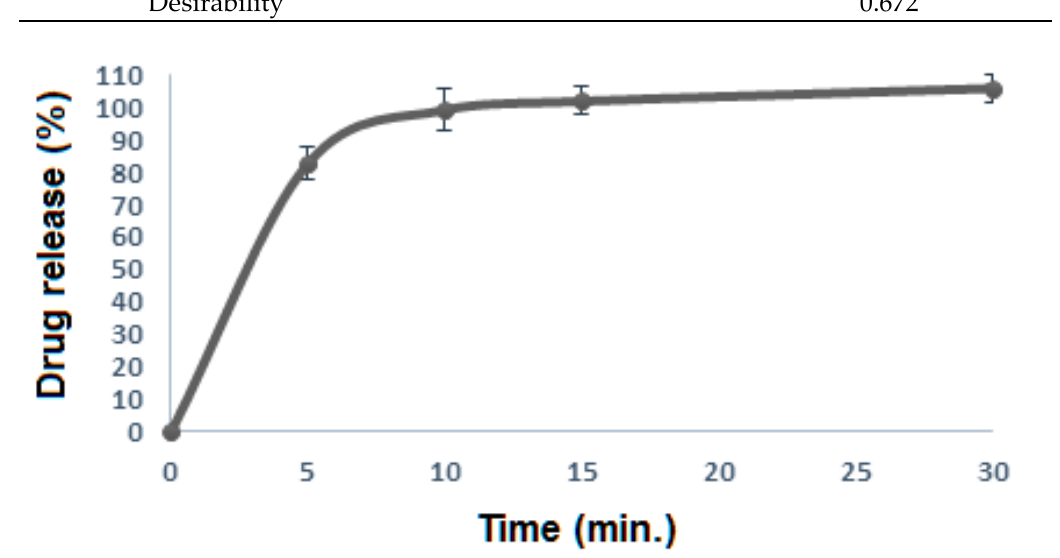
Table 5. Results of the optimized versus the predicted formula.